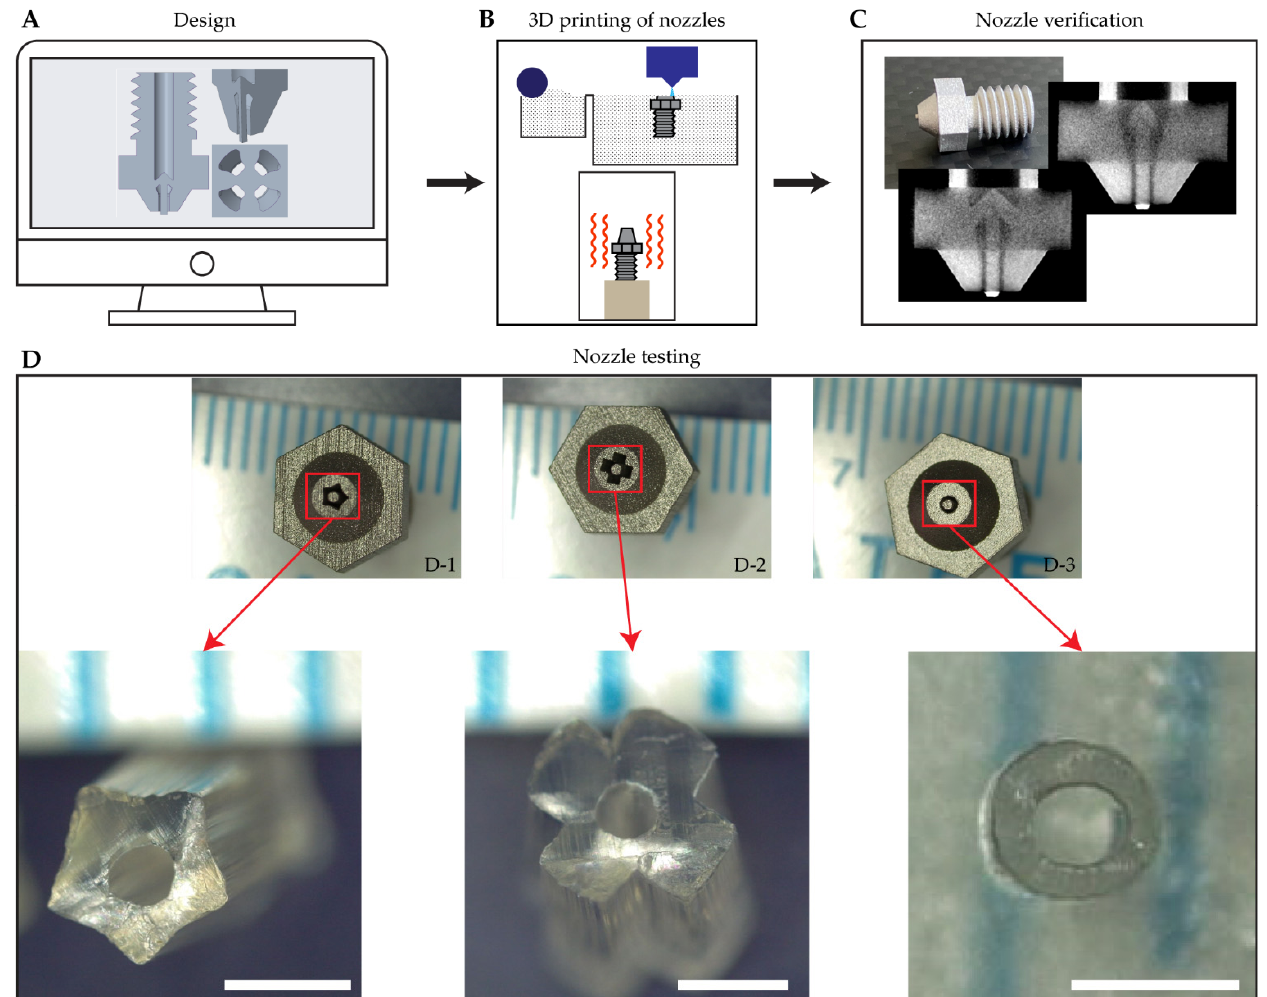
Figure 2. Methodology adopted to produce the extrusion nozzle used in the production of the tubes. Nozzle design ( A ), 3D printing of the nozzles ( B ), Nozzle’s internal structure verification ( C ), hot melt extrusion testing ( D ), scale bar represents 1 mm length.